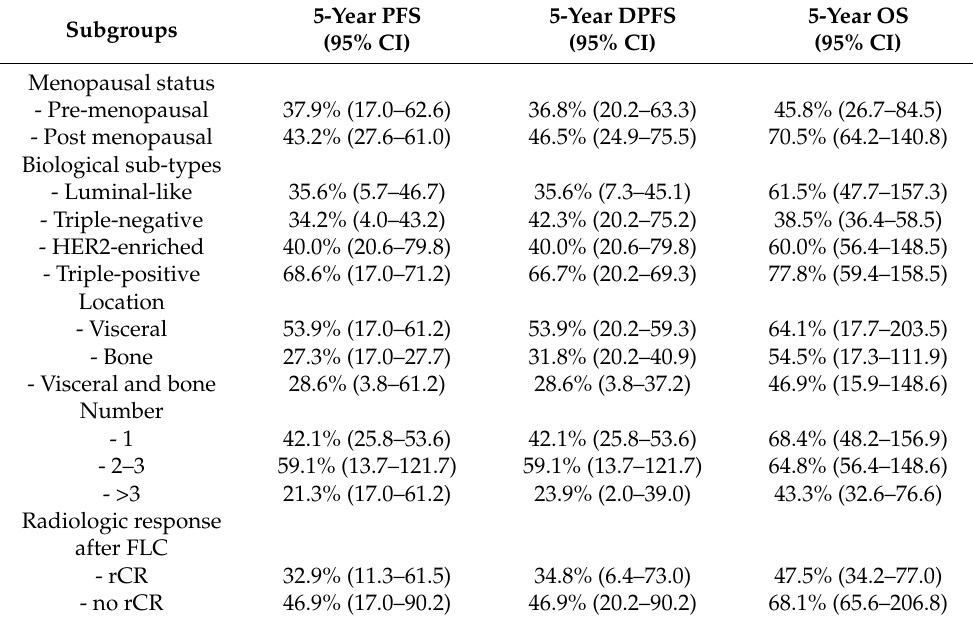
Table 2. Comparison of progression-free, distant progression-free, and overall survival rates of different subgroups of patients with de novo metastatic breast cancer.